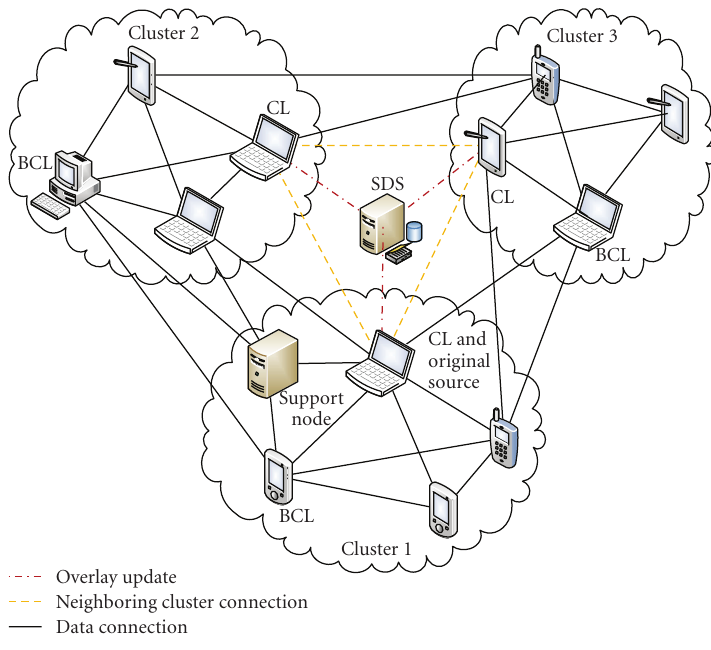
Figure 1: Overlay